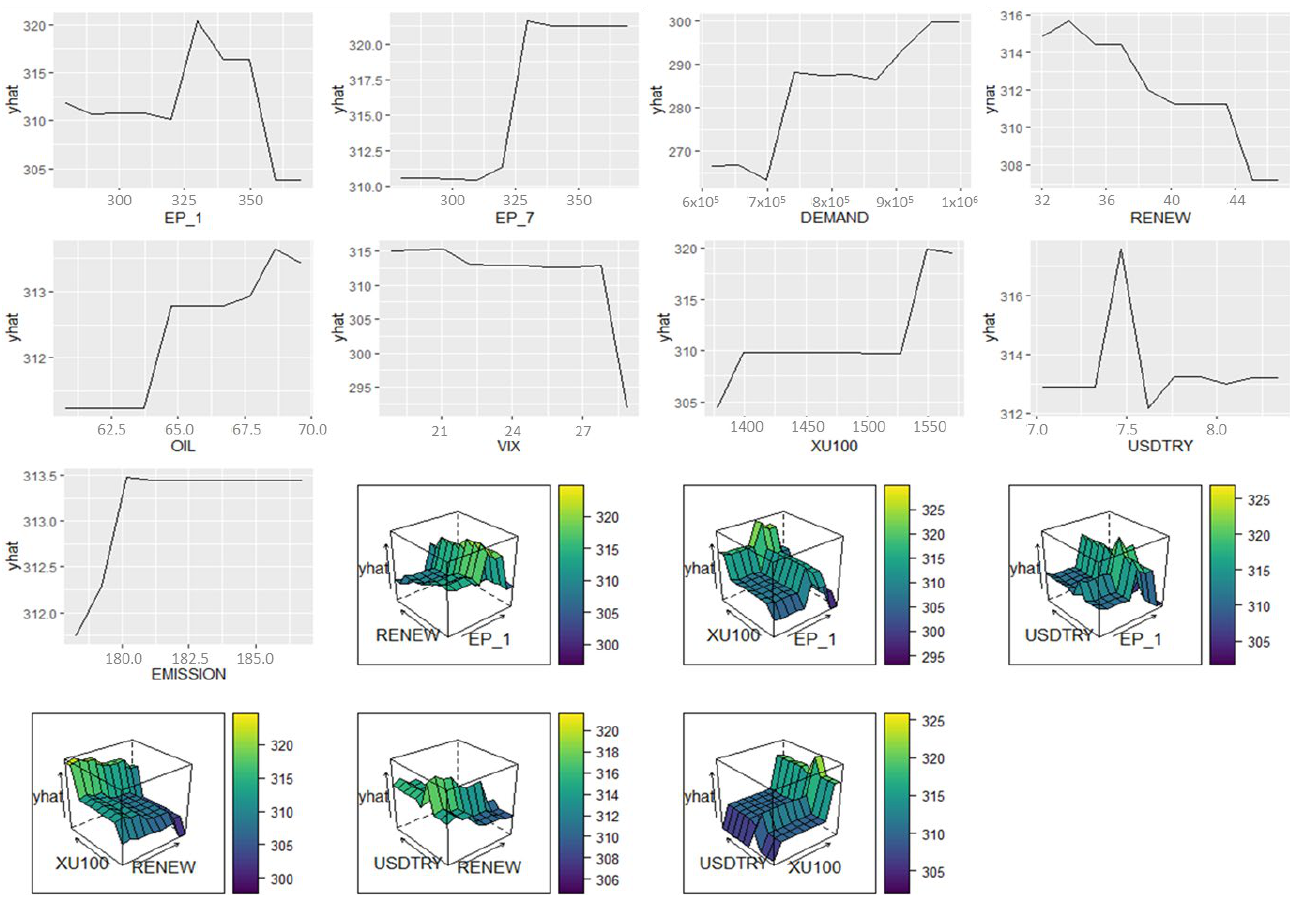
Figure 6. Single and interaction effects of independent v ariables in the pandemic period.